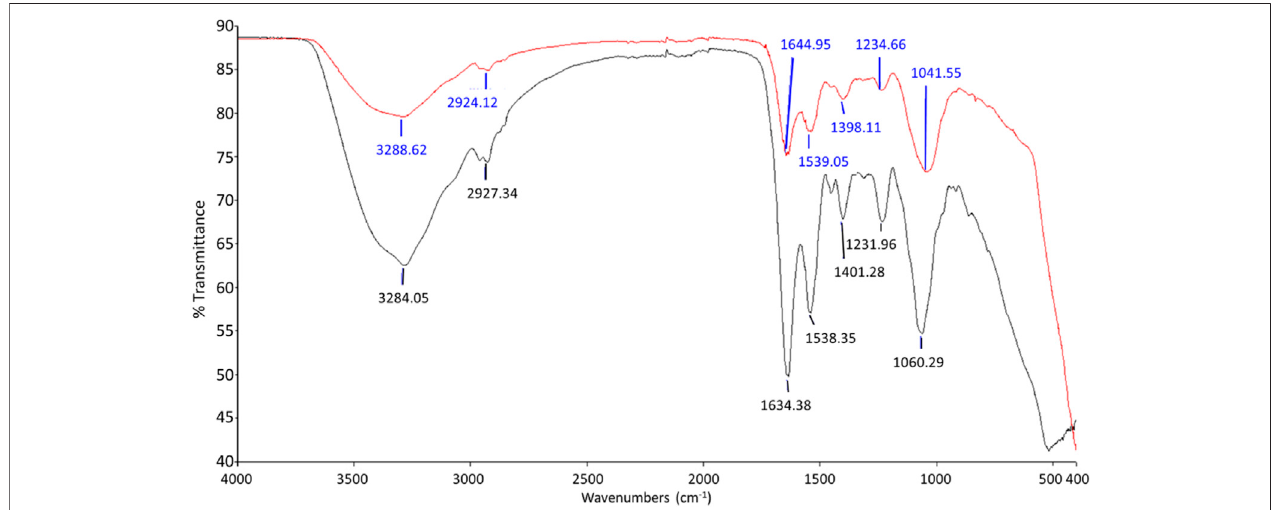
FIGURE 7 | FTIR spectrum of negative control (black line) and E. faecalis treated with 160 μ g/ml of ZnO NPs for 24 h (red line).